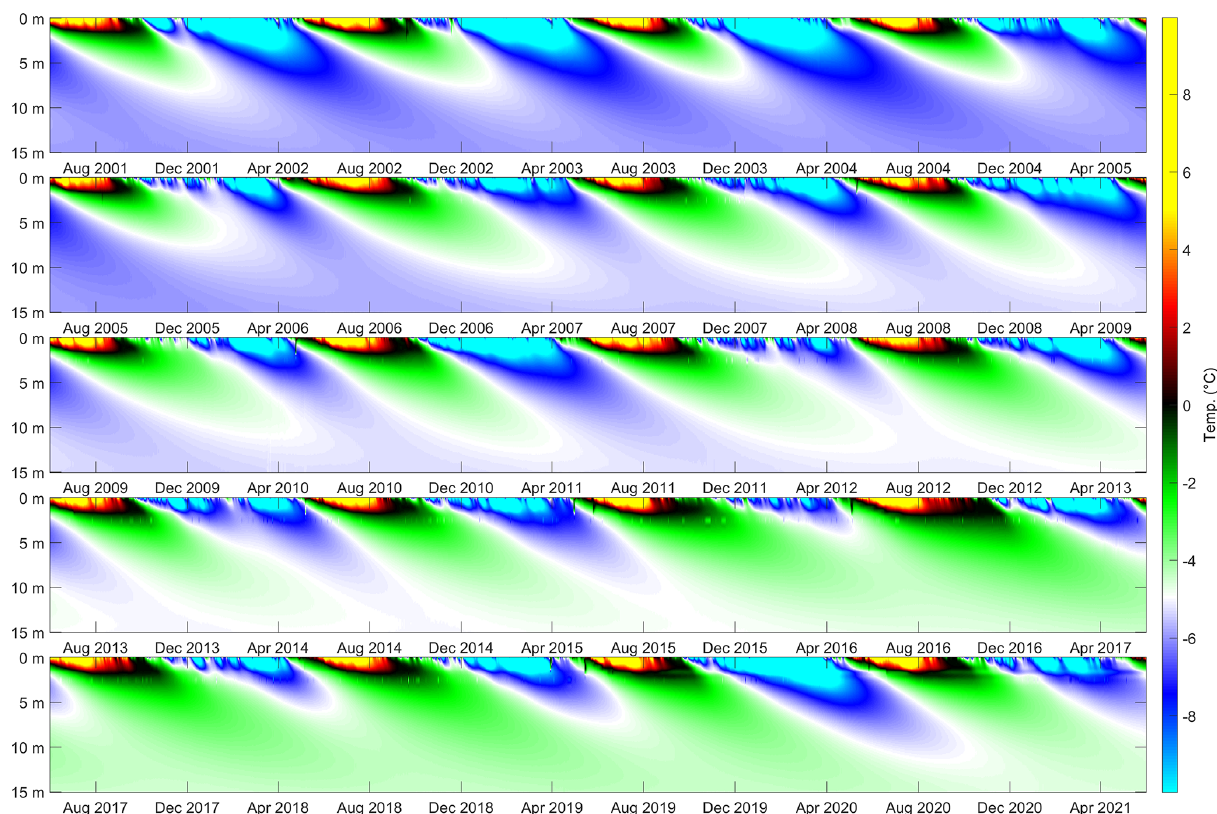
Figure 3. Illustration of spatiotemporal borehole temperature recorded at the PACE (Permafrost and Climate in Europe) P11 borehole on Janssonhaugen. A long-term warming trend is observed in the permafrost below the ∼ 2m thick active layer that is subject to a seasonal freeze–thaw cycle. The continuous timeline is split across multiple figure panels. The temperature–depth profile was interpolated to regular 10cm intervals using a spline